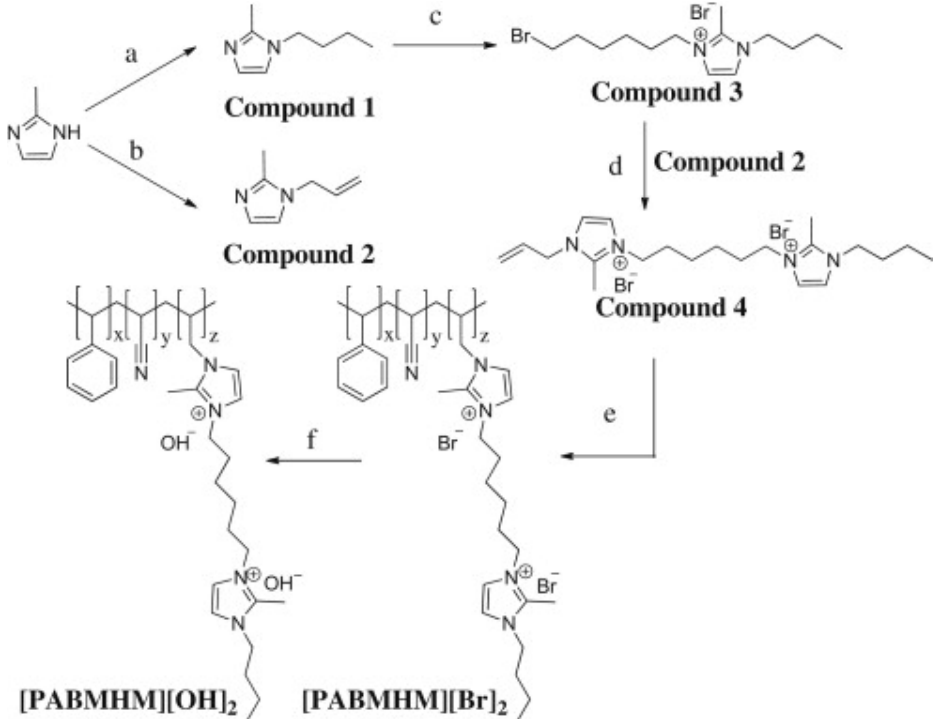
Figure 11. Synthetic procedure for AEMs: ( a ) 1-bromobutane, NaOH, RT, 4 h; ( b ) allyl bromide, NaOH, RT, 4 h; ( c ) 1, 6-dibromohexane, 50 °C, 2 d; ( d ) hydroquinone, 50 °C, 2 d; ( e ) styrene, NaOH, RT, 4 h; ( c ) 1, 6-dibromohexane, 50 ◦ C, 2 d; ( d ) hydroquinone, 50 ◦ C, 2 d; ( e ) styrene, acrylonitrile, DVB, photo-crosslinking, 0.5 h; and ( f ) 1 M KOH, 60 °C, 24 h (Reprinted with acrylonitrile, DVB, photo-crosslinking, 0.5 h; and ( f ) 1 M KOH, 60 ◦ C, 24 h (Reprinted with permission permission from ref. [156] Copyright 2012 Elsevier.). from ref. [156] Copyright 2012